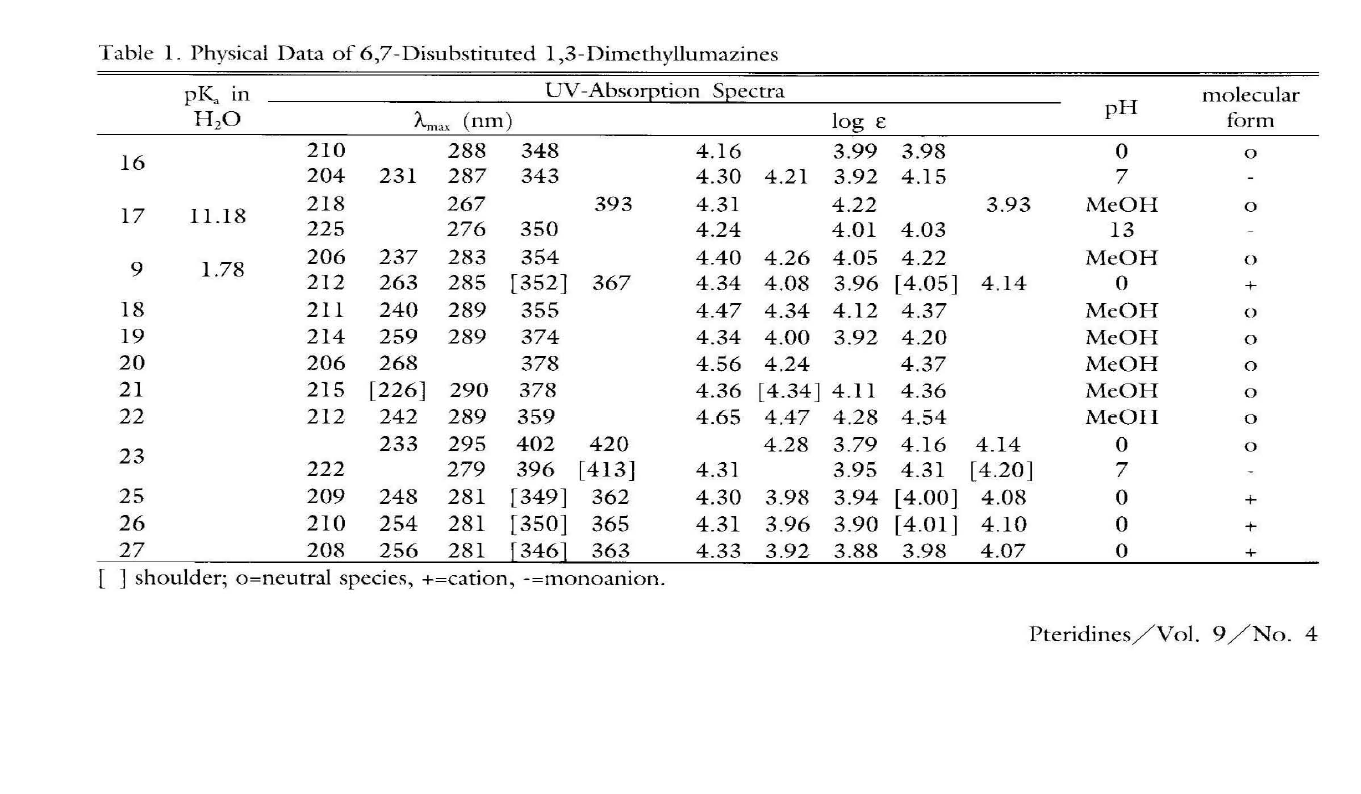
Table 1. Physical Data of6,7-Disubstituted 1,3-Dimcthyllumazines pI",